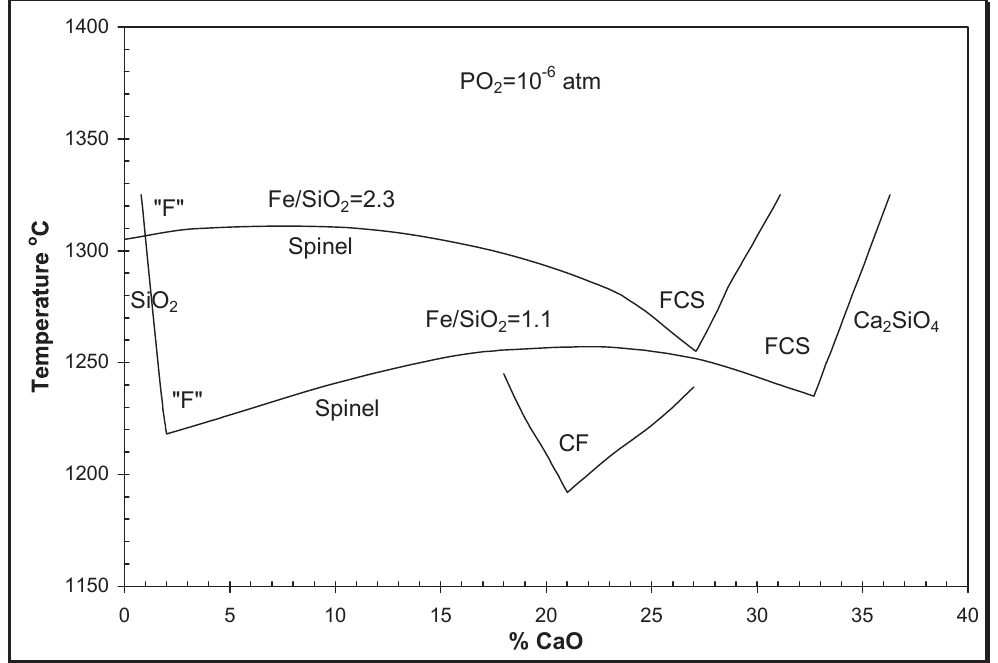
D 10 (cid:3) 6 atm. “F”: “fayalite” slag; 2